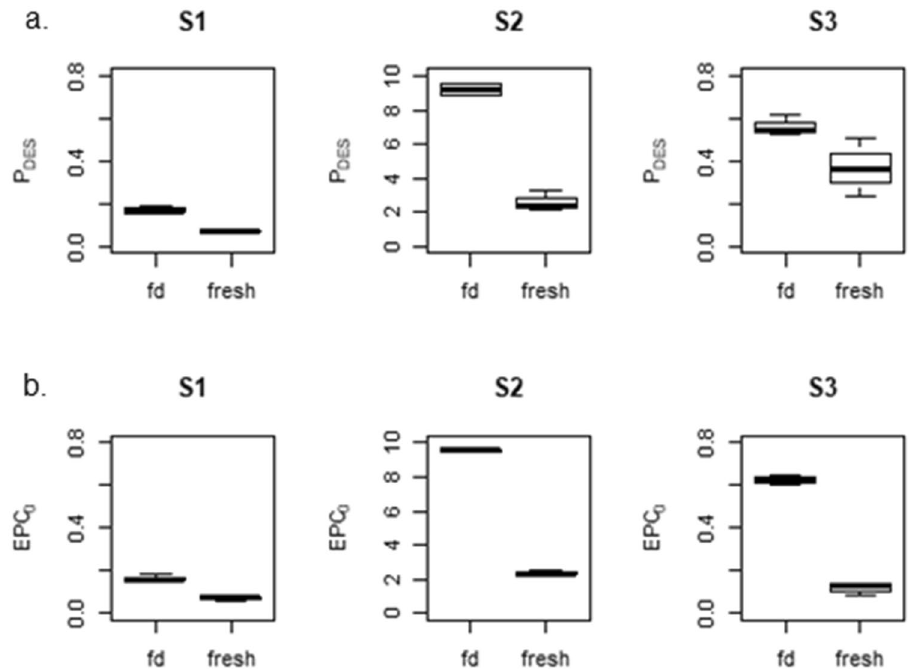
Fig. 3 Box plots illustrating the differences in the desorbable P (a, P ; µmol l −1 ) and in equi- DES librium P concentration at zero net P sorption (b, EPC ; µmol 0 l −1 ) of the fresh and the freeze- dried (fd) sediments (n = 3, except for the fd S2 n = 2). Note the different scale in